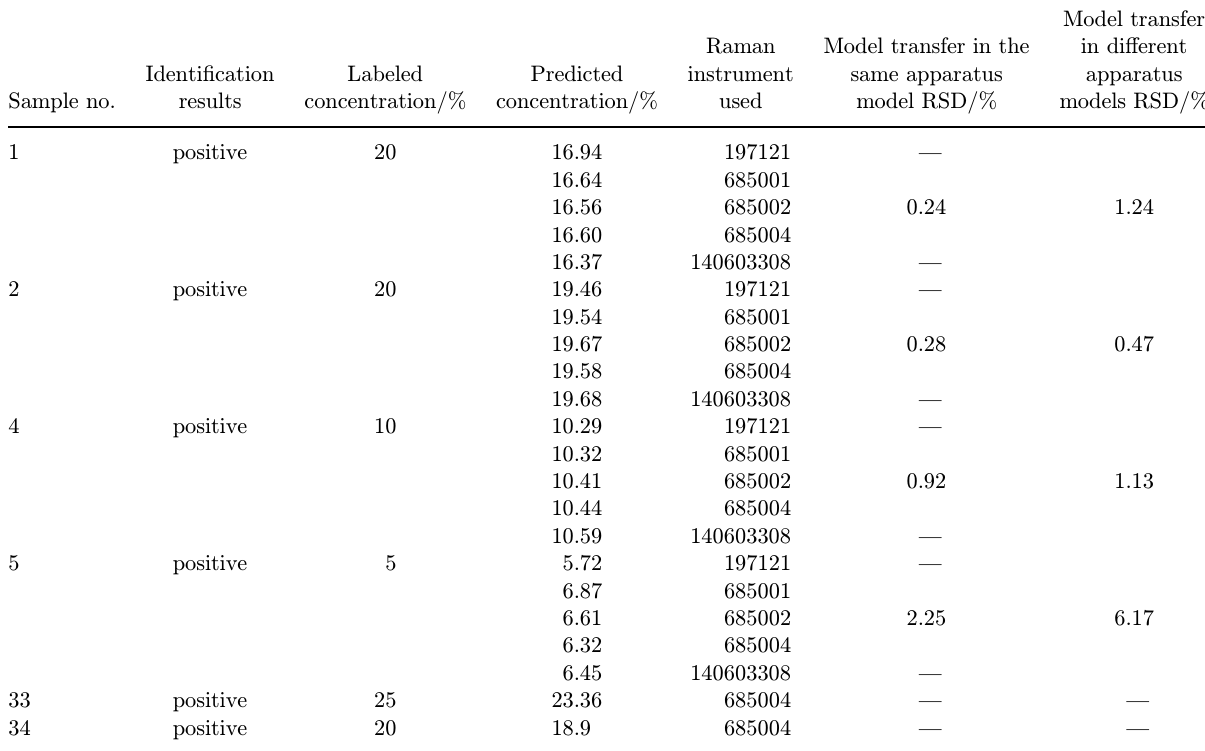
Table 4. Veri¯cation results of quanti¯cation and model